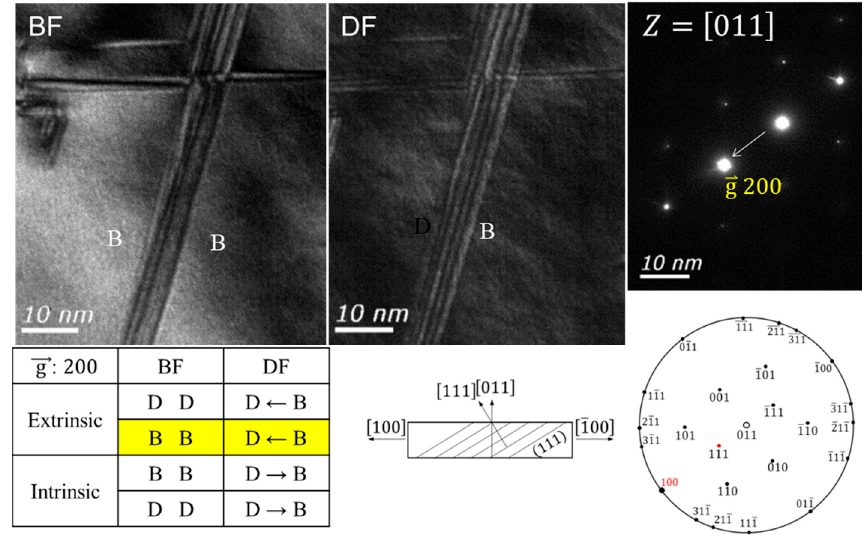
Figure 8. Image of a stacking fault in an LDX-2101 10% tensile strained specimen under a 200 two-beam diffraction condition.